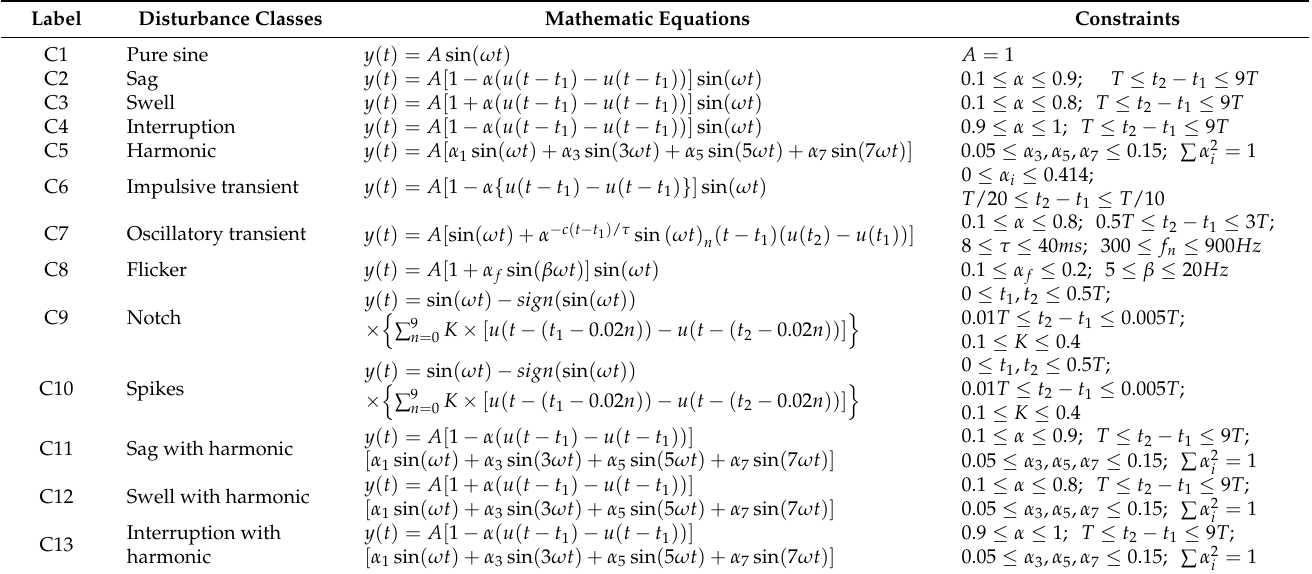
Table 1. Power quality disturbance’s mathematical equations, adapted from: